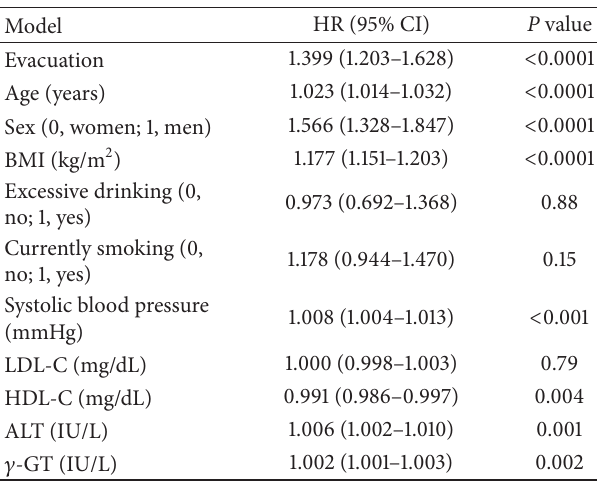
Table 4: Hazard ratios (HR) and 95% confidence intervals (CI) of diabetes for risk factors after the Great East Japan Earthquake: the Fukushima Health Management Survey